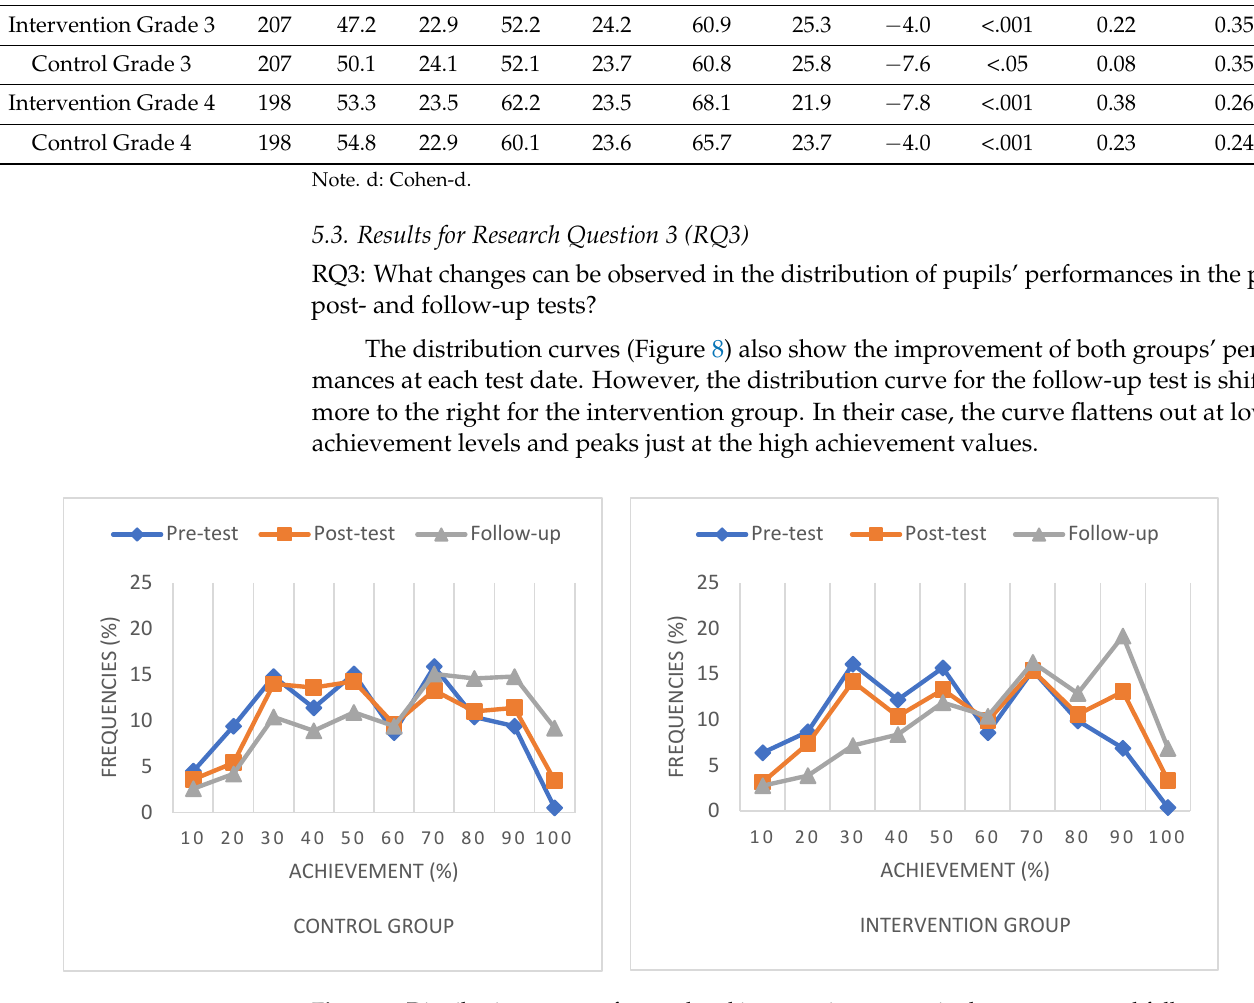
Figure 8. Distribution curves of control and intervention groups in the pre-, post- and follow-up tests.